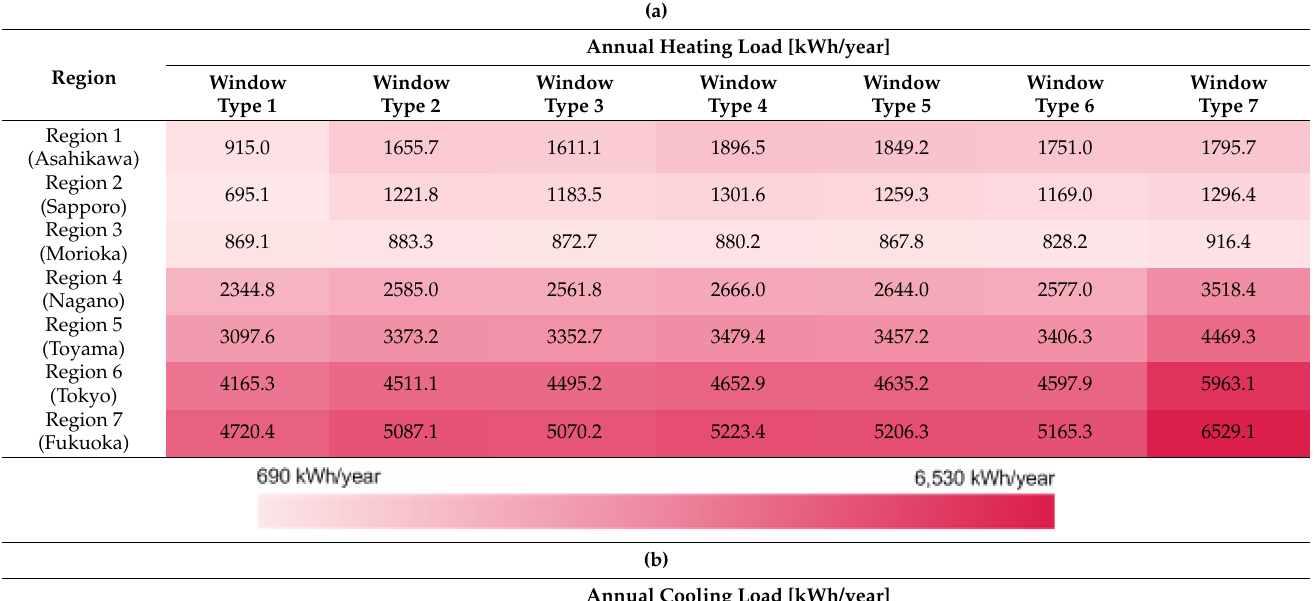
Table 5. ( a ) Annual heating load by window configurations. ( b ) Annual cooling load by window configurations. ( c ) Annual total heat load by window